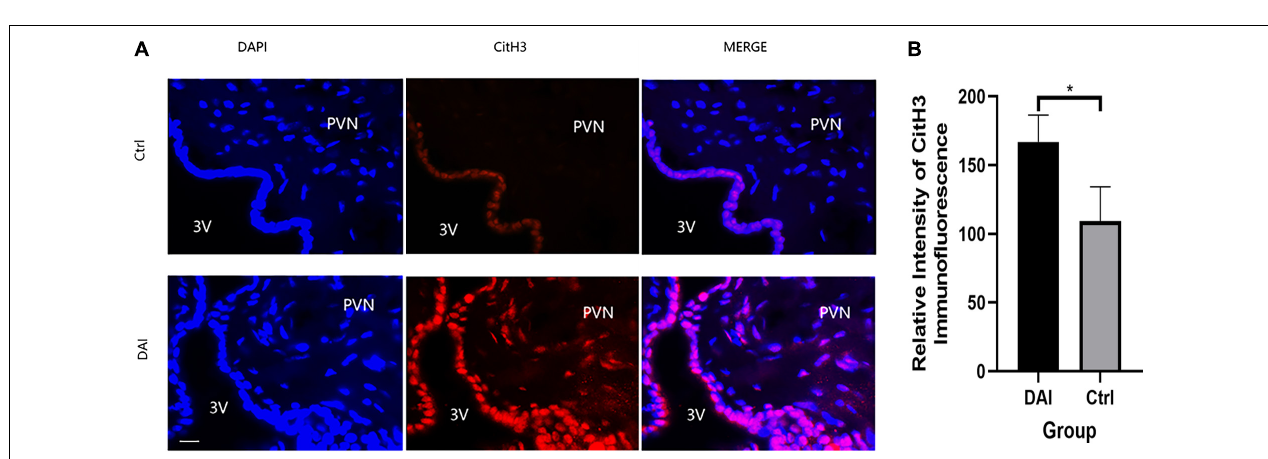
FIGURE 3 | (A) Flow cytometric detection of NETs formation in circulating blood neutrophils of rats 72 h after DAI. (B) Proportion of CitH3 + and MPO + double-positive cells in experimental and control groups (* P < 0.05). Grouping: DAI group ( n = 10) and control group ( n = 6). CitH3, Citrullinated histone H3; MPO, myeloperoxidase.